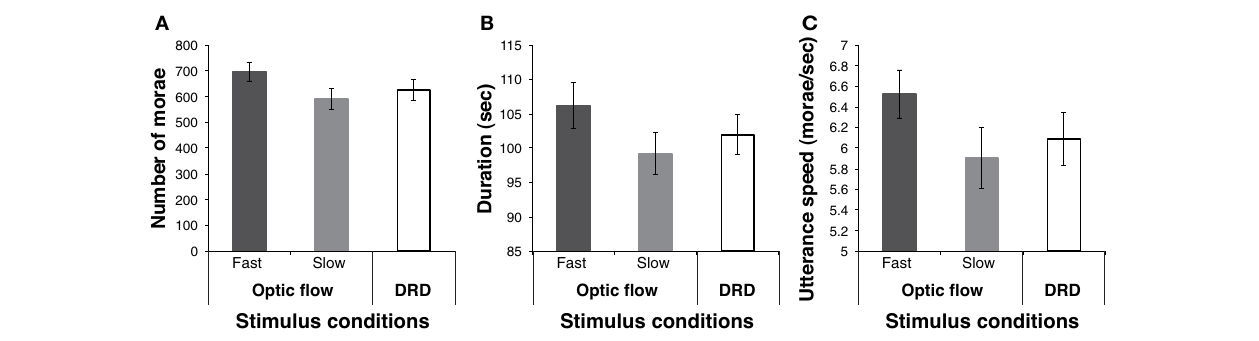
FIGURE 1 | Results of the experiment. The results for (A) number of morae, (B) speech duration, and (C) utterance speed in each of the stimulus conditions are shown. The labels “Fast” and “Slow”